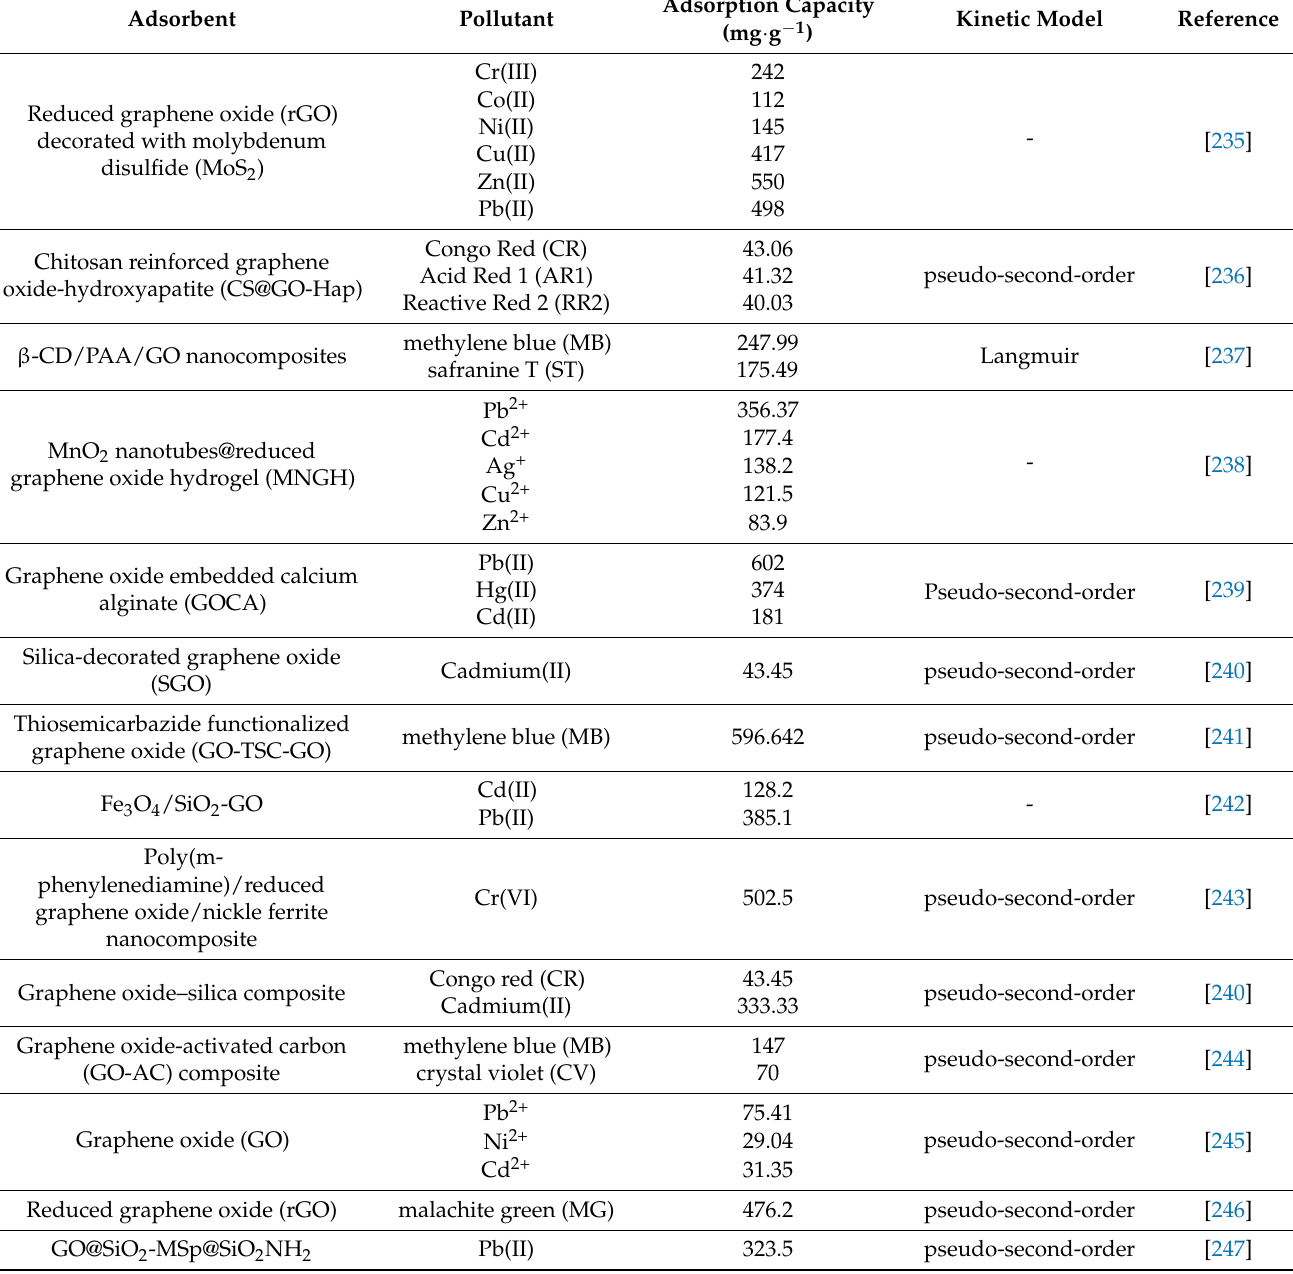
Table 9. Application of graphene and its derivatives in the removal of heavy metals and dyes from water for water treatment. Adsorbent